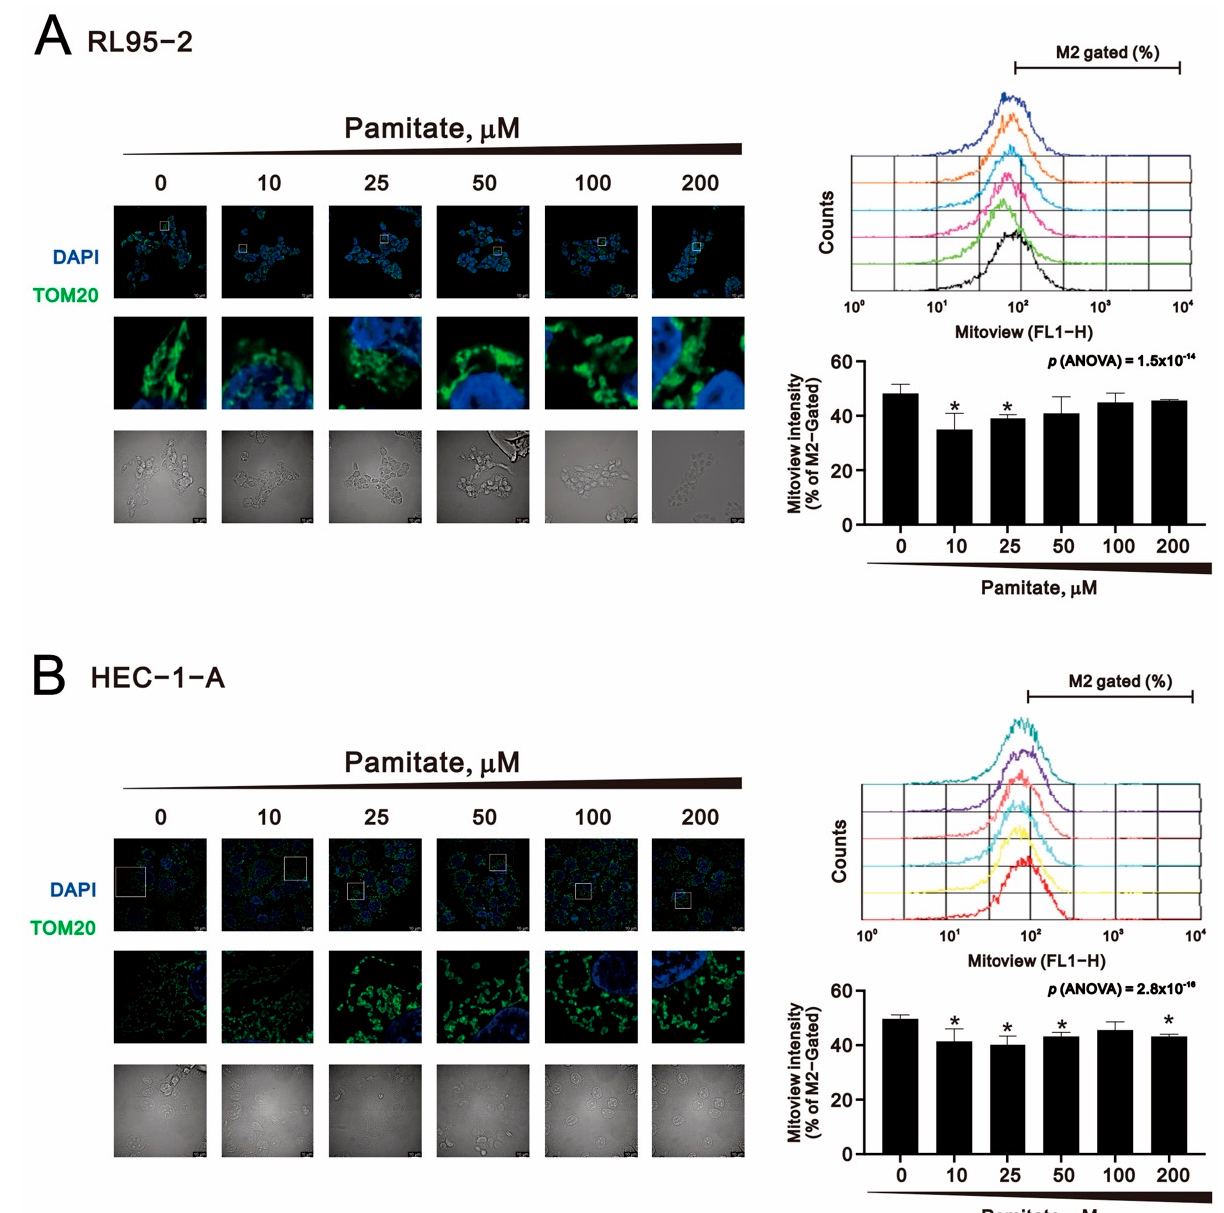
Figure 9. Effects of palmitate on mitochondrial morphology in human endometrial cancer cells. ( A ) RL95-2 and ( B ) HEC- 1-A cells were treated for 1.5 h with the indicated concentrations of palmitate, after which they immunostained for TOM20 (mitochondria, green). Nuclei were stained with 4 ′ ,6-diamidino-2-phenylindole (DAPI, blue). Images were obtained using a Leica THUNDER Imager microscope (100x oil-immersion objective). Scale bar: 10 μ m. Mitochondrial mass was assayed using MitoView TM Green with flow cytometry. Traces are representative of three independent experiments. Bars depict the mean ± SD of three independent experiments. * p < 0.05 (Student’s t -tests).